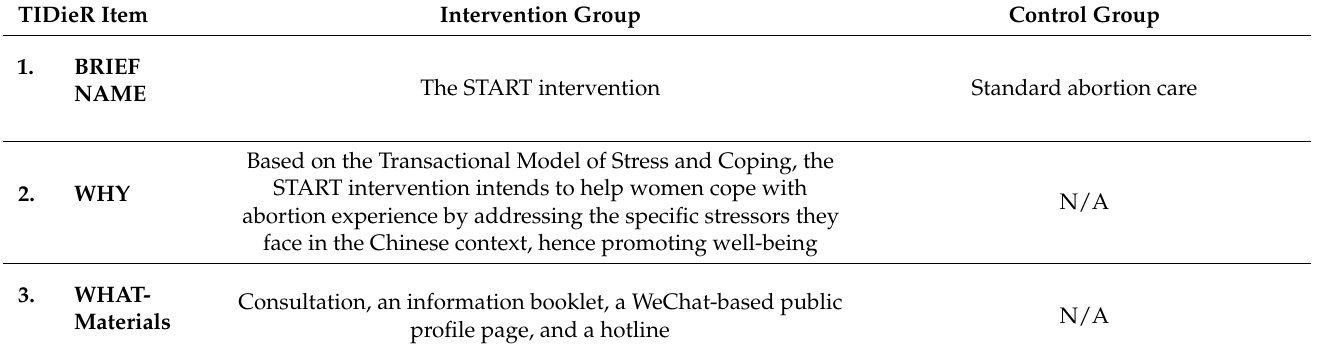
Table 1. Intervention description according to TIDieR